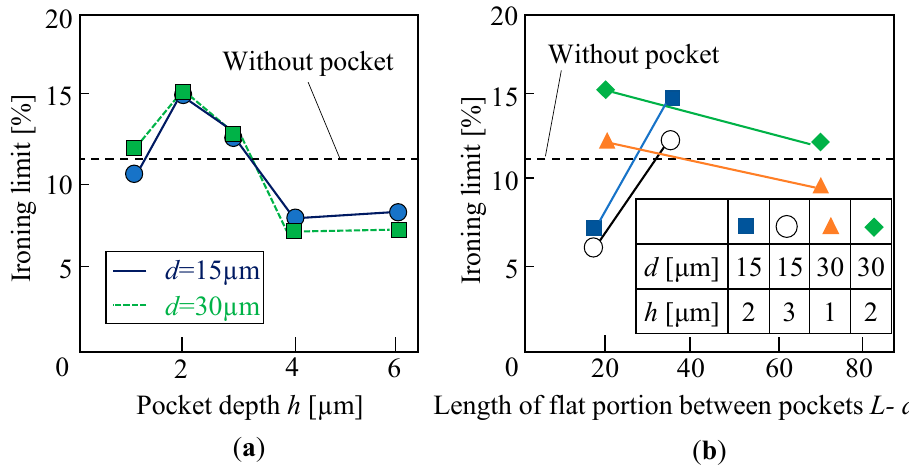
Figure 11. E ff ect of ( a ) pocket depth at L = 50 µm and ( b ) length of fl at portion between pockets on Figure 11. Effect of ( a ) pocket depth at L = 50 µ m and ( b ) length of flat portion between pockets on the ironing limit with grid array pa tt ern. the ironing limit with grid array pattern.